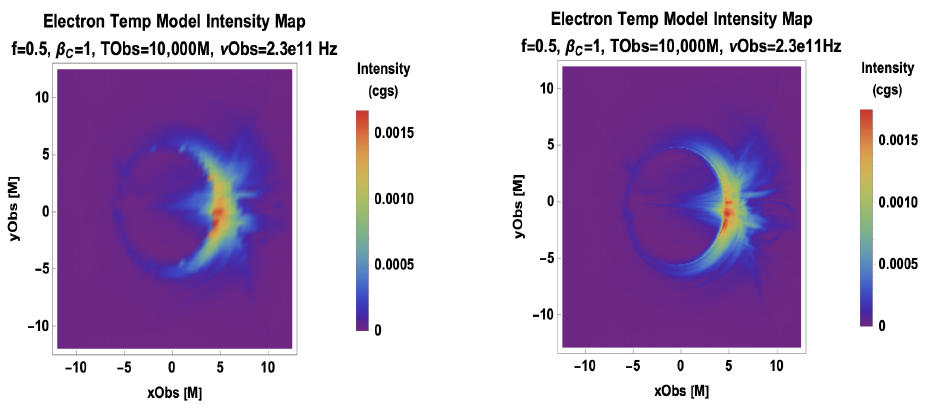
Figure A1. Resolution dependence of the Critical Beta Model. Increasing from 2 pixels/ M to 10 pixels/ M alters the image morphology such that the overall image is sharper and the brightest features are more localized and extreme in